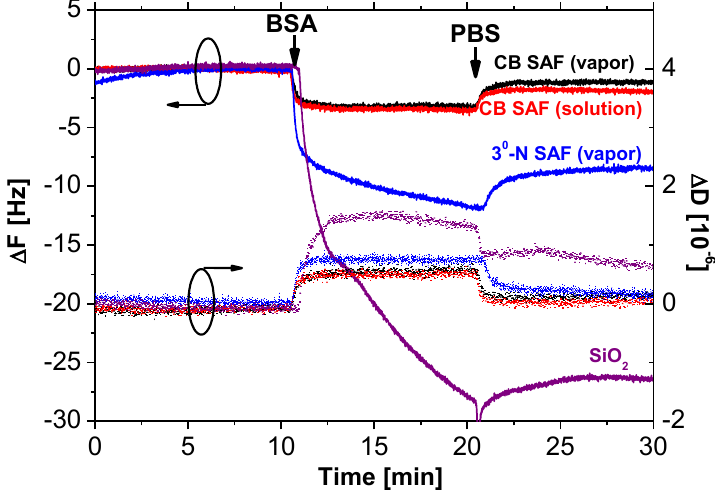
Figure 4. QCM-D measurements of the protein fouling on samples of CB SAF (vapor), CB SAF (solution), 3°-N SAF (vapor) and bare SiO solutions at a concentration of 1 mg·mL −1 were brought to contact with surfaces for 10 min, followed by rinsing with